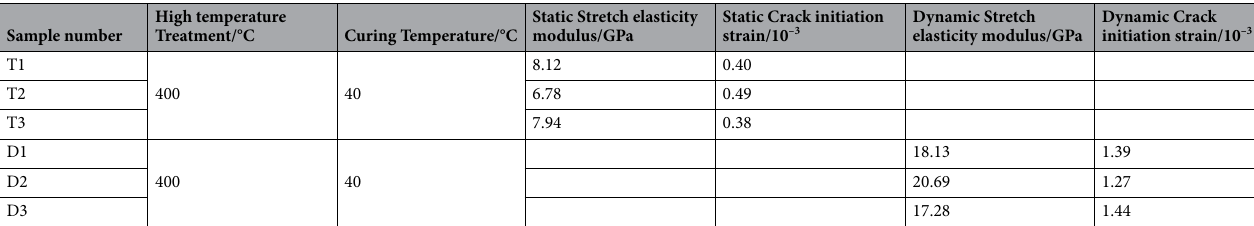
Table 2. Experimental results of tensile strength parameters of